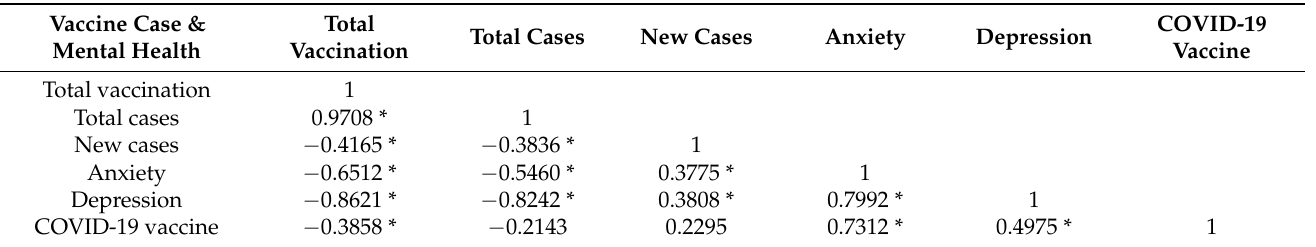
Table 4. The Pearson correlations between total vaccination, total cases, new cases, anxiety, depression, and COVID-19